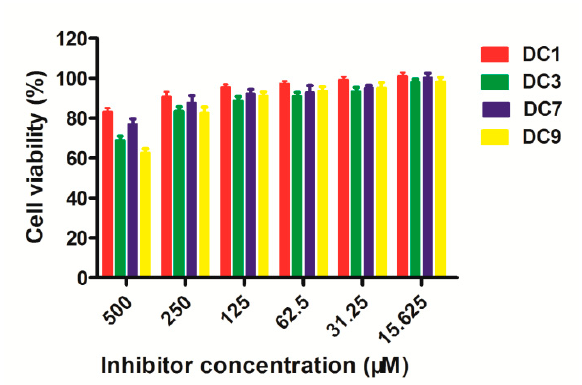
Figure 6. Percent cell viability (relative to viability without compound) of L-929 mouse fibroblastic cells, in the presence of DC1, DC3, DC7 or DC9, at concentrations ranging from 15.6 to 500 μ M.